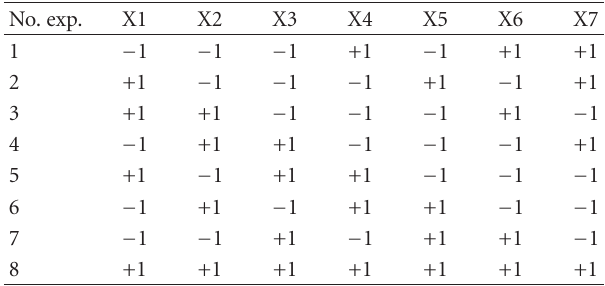
Table 2: Plackett-Burman experimental design (coded values). No.